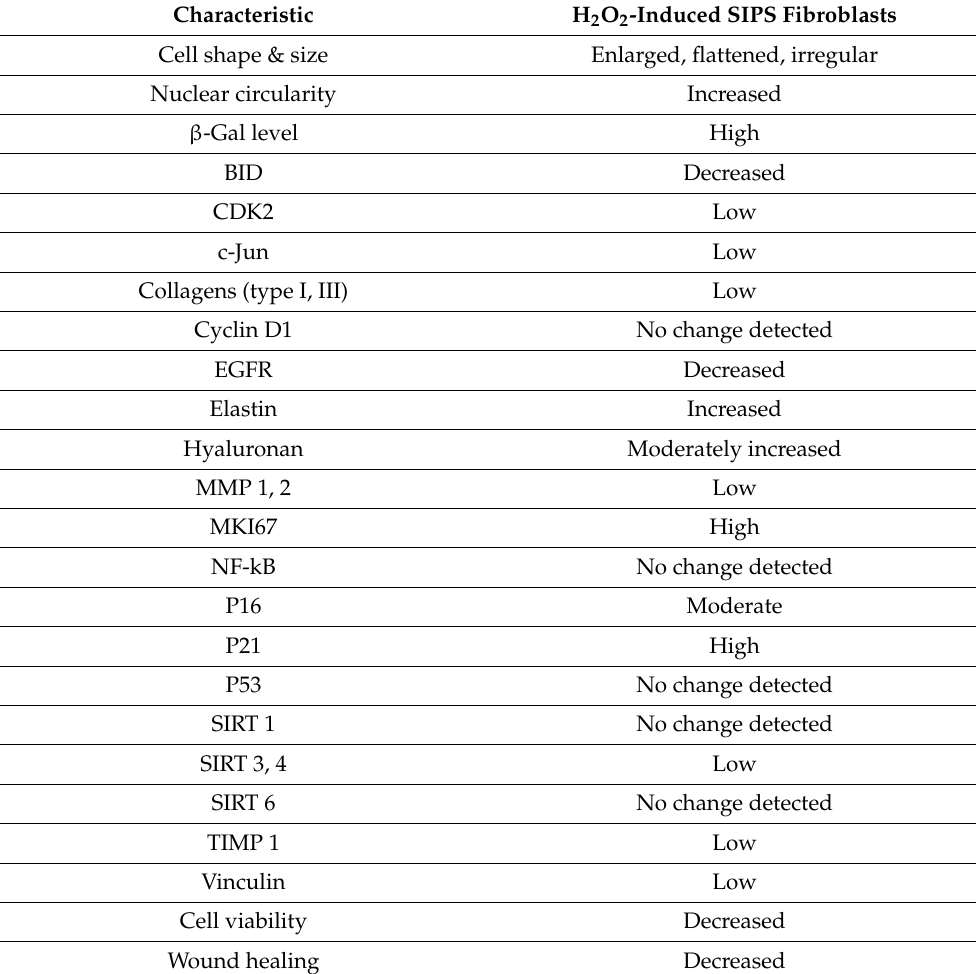
Table 2. Summary of the investigated characteristics of H 2 O 2 -induced prematurely aged skin fibrob- lasts compared to untreated